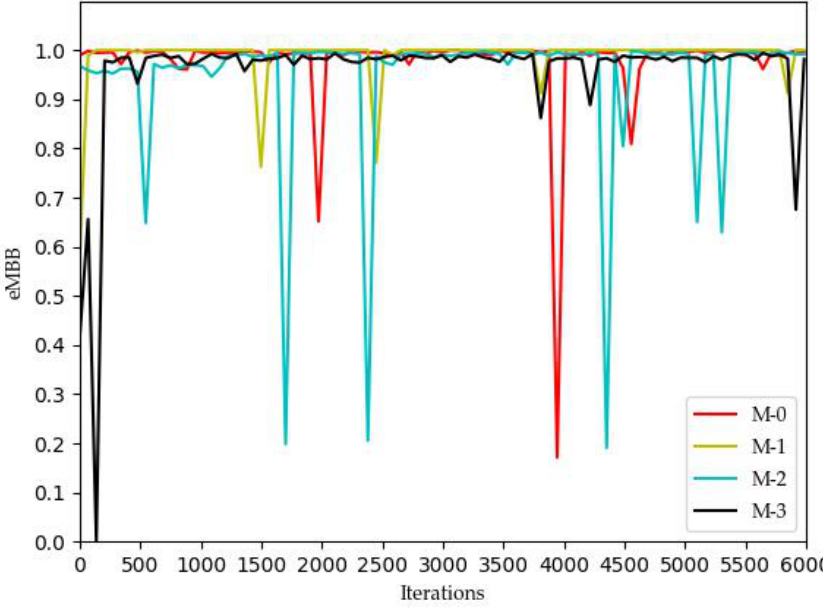
Figure 4. Optimization curve of QoE of eMBB for each MVNO in the lower model based on DQN.